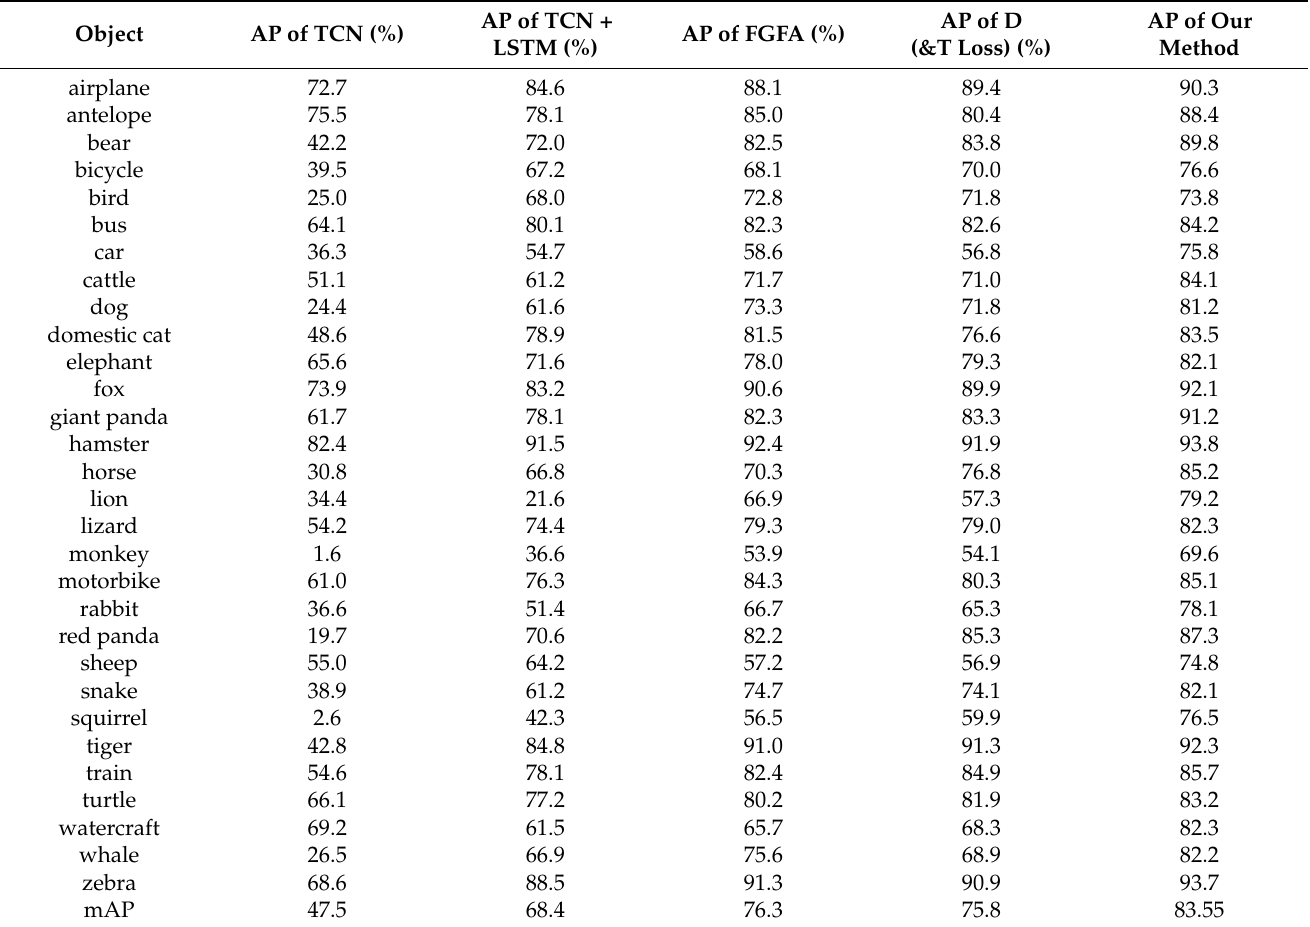
Table 3. Comparison of AP and mAP of each method on the ImageNet VID dataset.